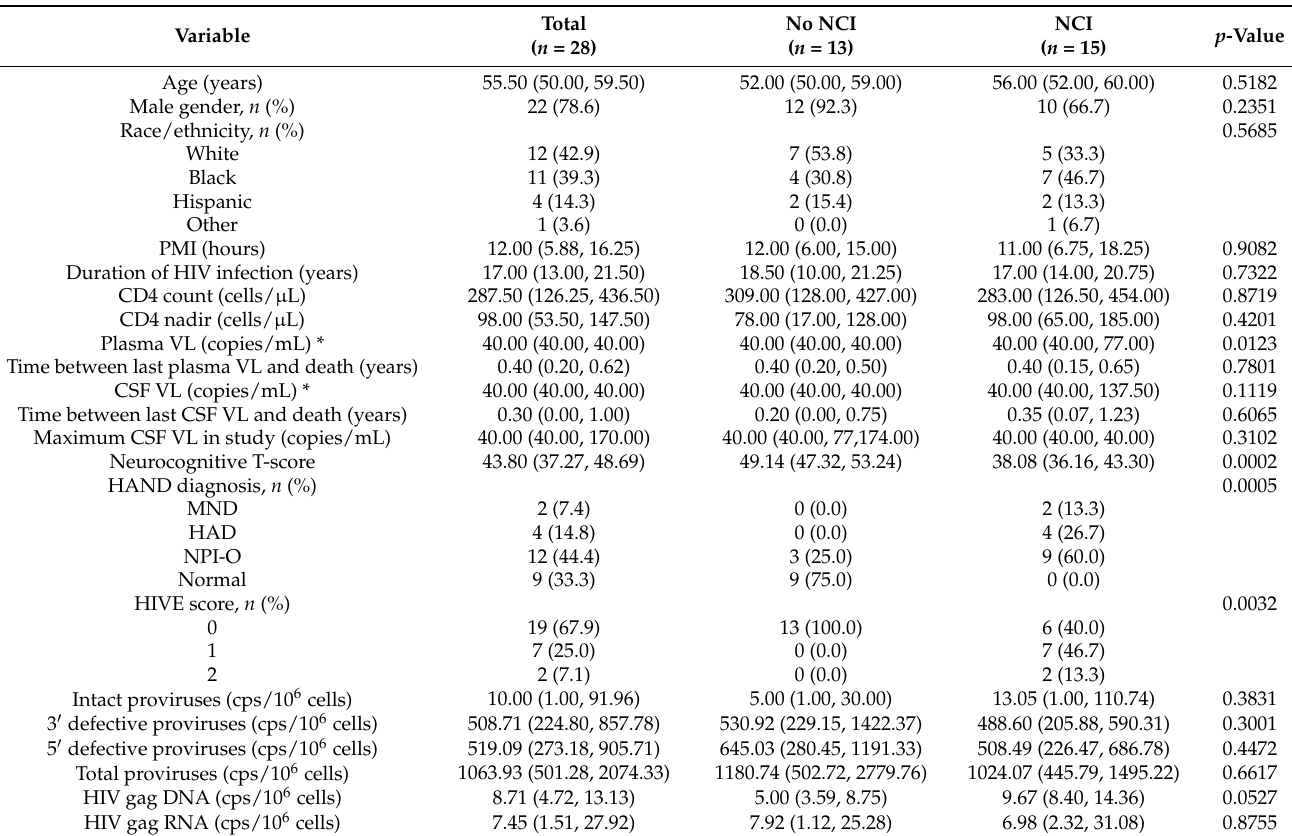
Table 1. Clinical and virological characteristics of the study cohort by neurocognitive status.